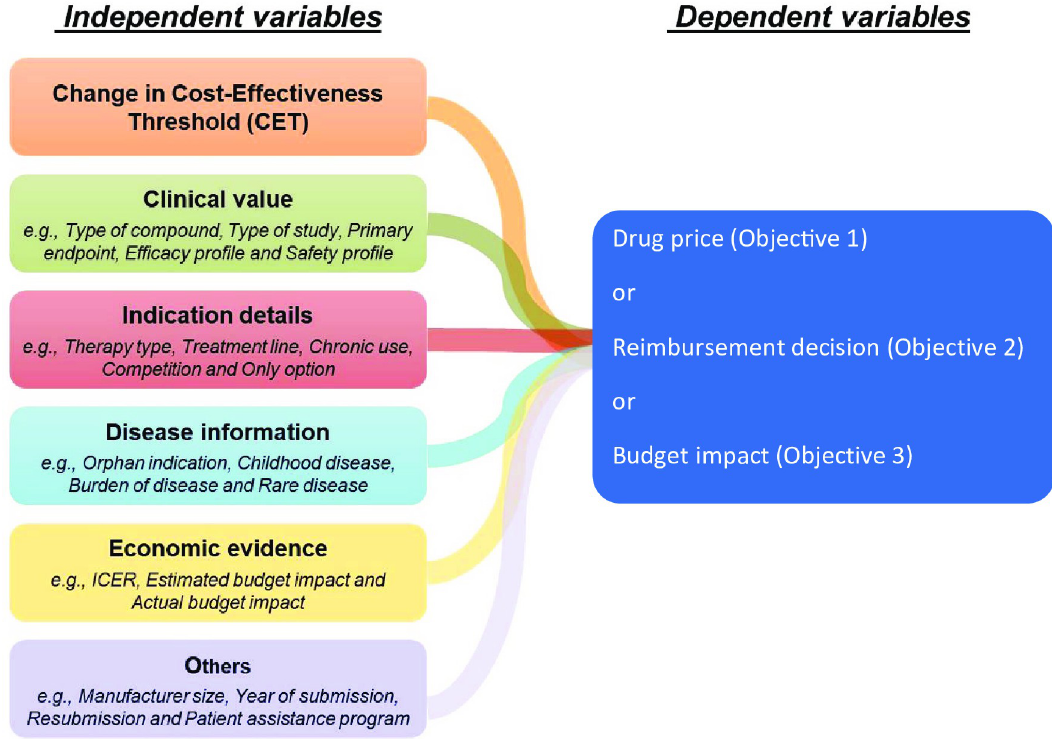
Fig 2. Independent and dependent variables in the